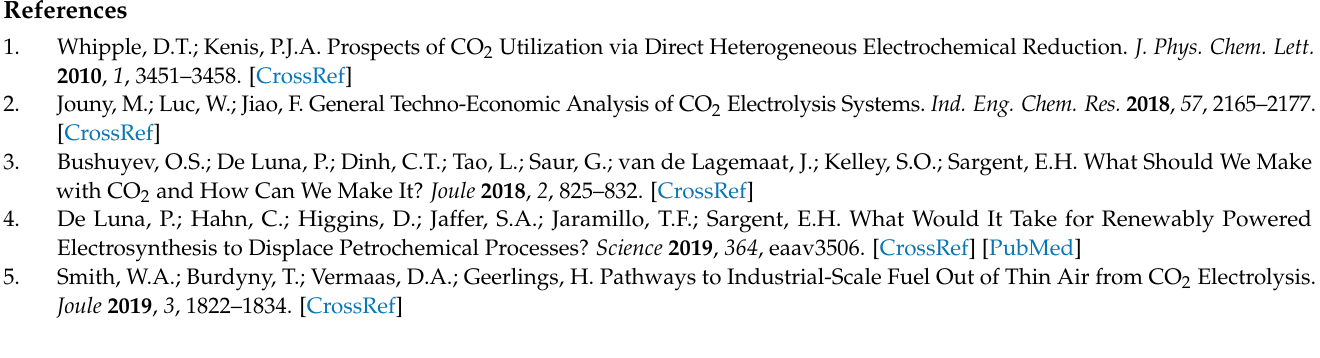
(Figure S1), Optical Spectra (Figure S2), Full Cyclic Voltammetry Data in Triplicate (Figures S3–S60), Differential Pulse Voltammetry (Figure S61), Scan Rate Analysis (Figures S62 and S63), Current Response Versus Loading Analysis (Tables S1 and S2, Figures S64 and S65), Foot-of-the-Wave Analyses (Table S3, Figures S66–S74), Plateau Current Analysis (Table S4), Catalyst Stability